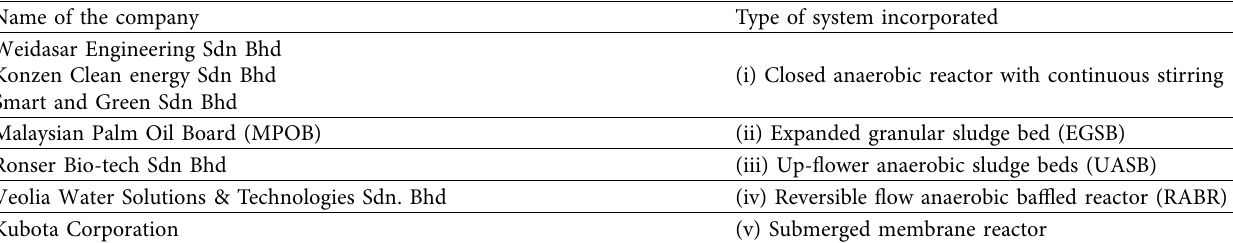
Table 4: Biogas capture technologies with the respective company in Malaysia